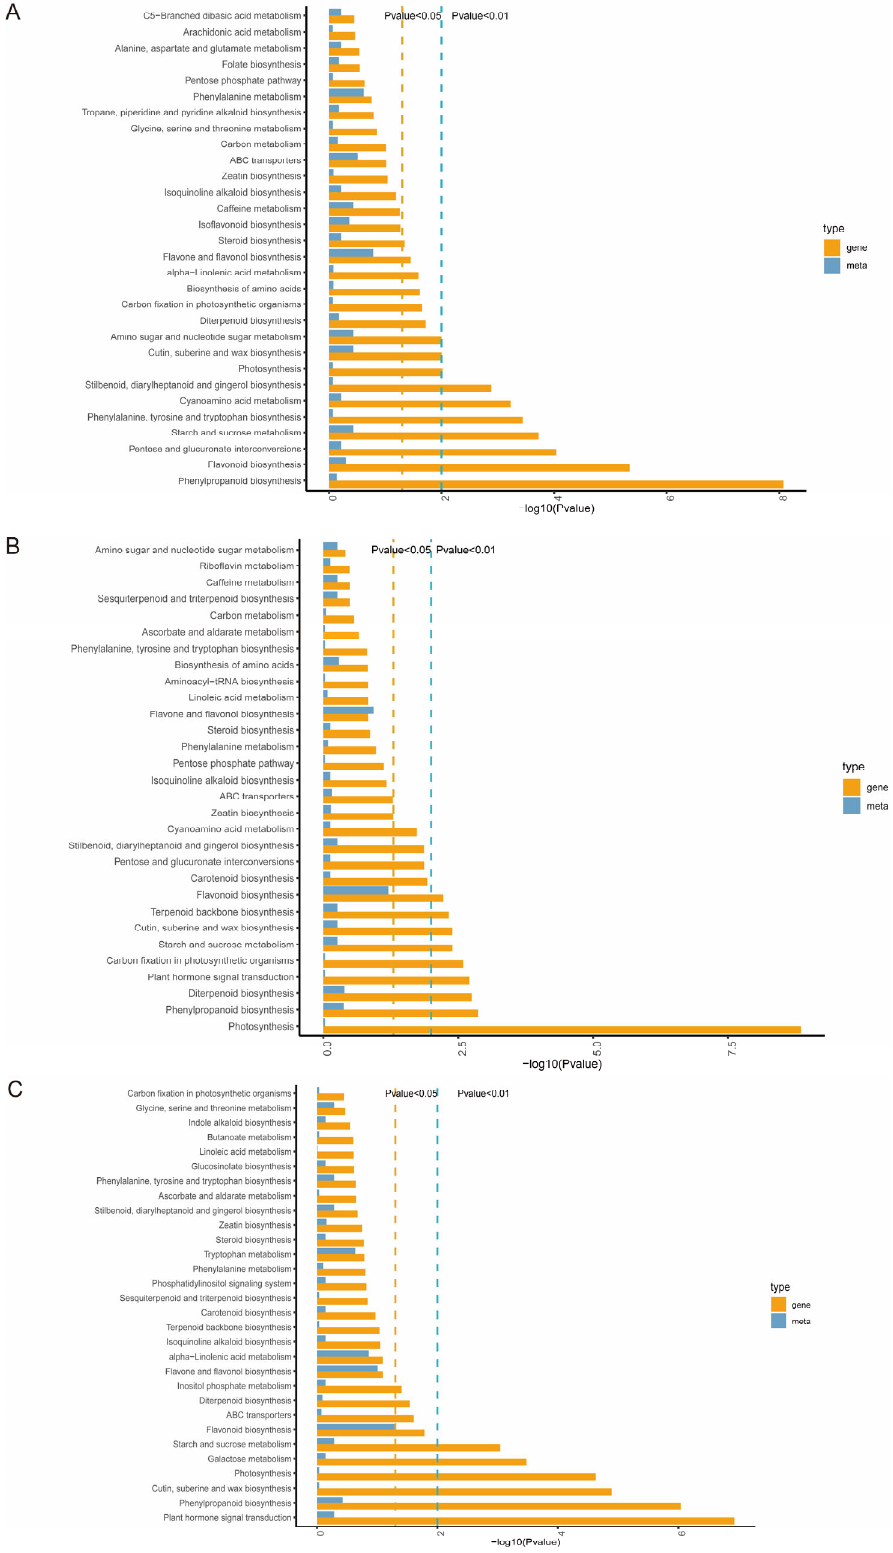
Figure 7. KEGG pathway enrichment of DEGs and DAMs, ( A ) with S2/S1, ( B ) with S3/S1, and ( C ) with S4/S1.